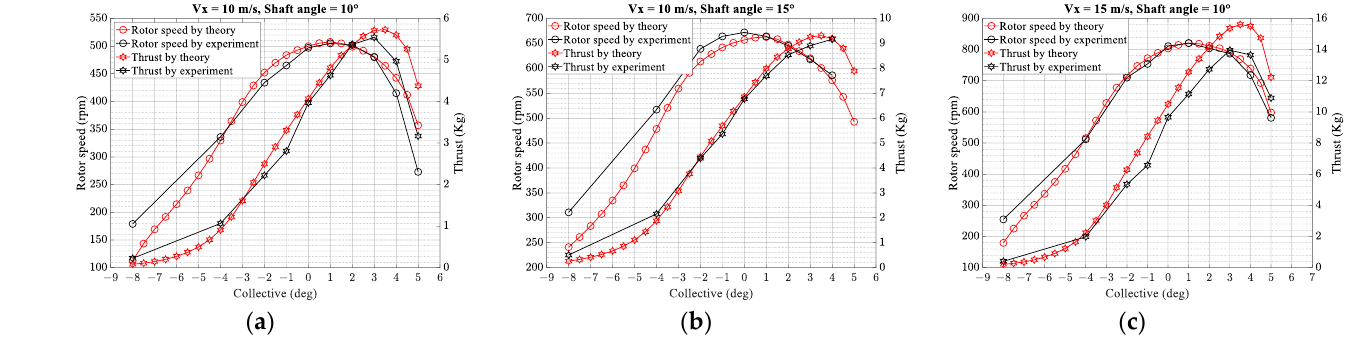
Figure 6. Comparison between experimental and theoretical rotor speed and thrust at steady auto- rotation: ( a ) 10 m / s , tation: ( a ) V x = 10 m/s, θ = 10 deg; ( b ) V x = 10 m/s, θ = 15 deg; ( c ) V x = 15 m/s, θ = 10 deg.